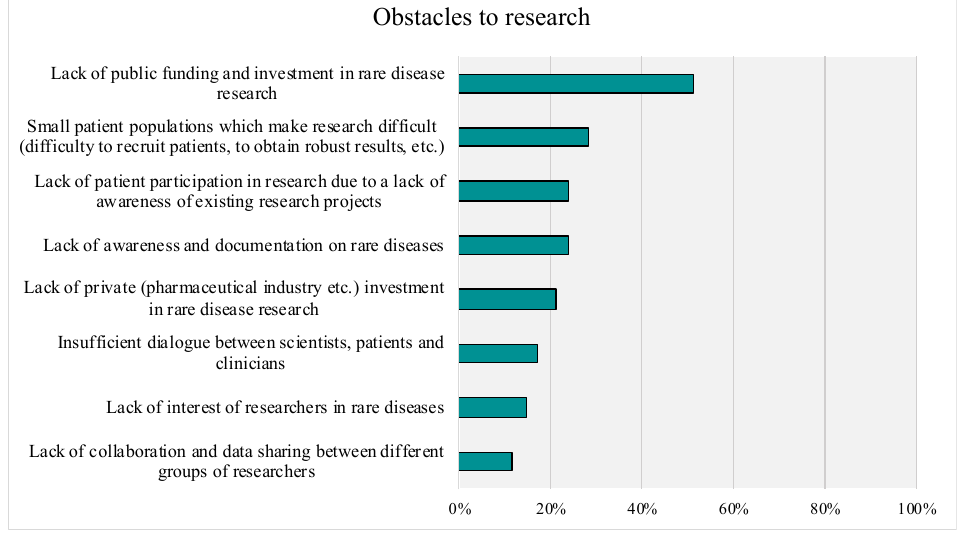
Figure 10. Obstacles to Research. Top ‐ Box answers ( “Largest Obstacle” rankings) are Presented.